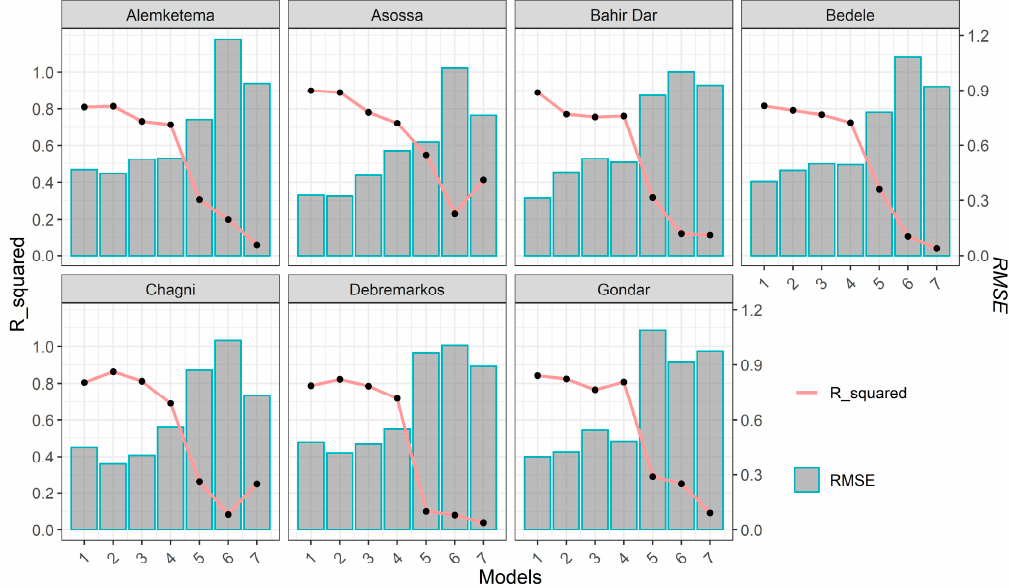
Figure 6. Comparison of performance of the seven models at a 12 months time scale.